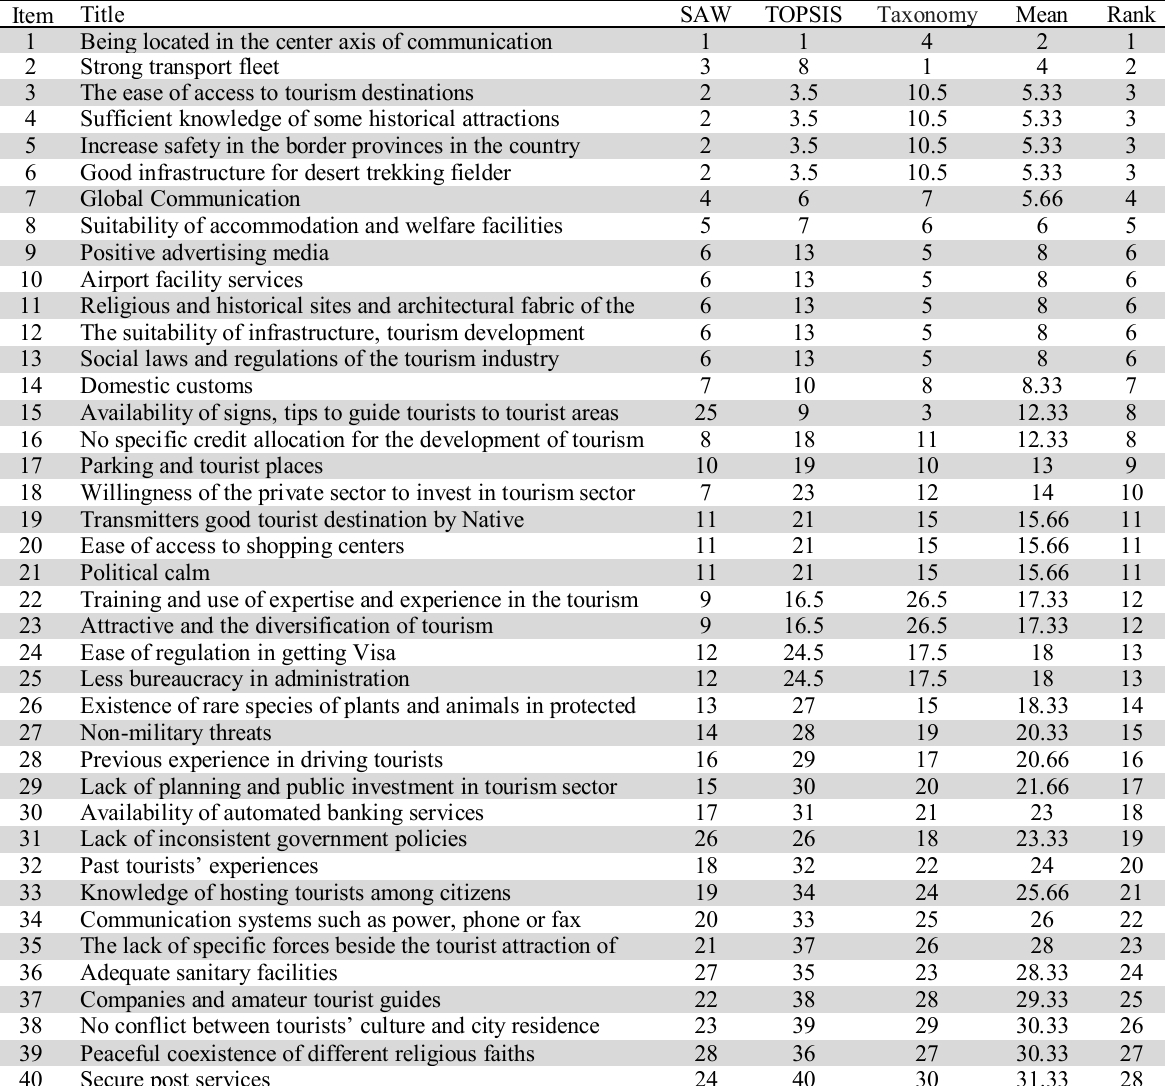
The summary of ranking factors based on TOPSIS, SAW and